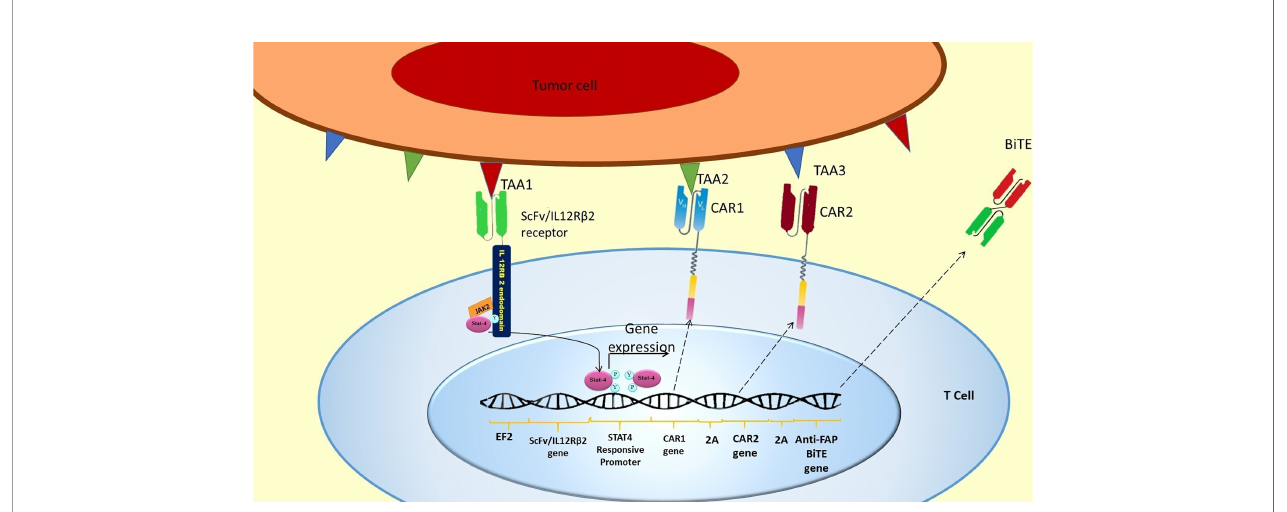
FIGURE 3 | SCFV/IL-12R b 2 receptor induces CAR genes expression. The hypothetically designed cells express ScFv/IL-12R b 2 receptor constitutively before injection. The ScFv/IL-12R b 2 receptor consists of an extracellular domain against tumor-associated antigen 1 and the intracellular domain of b 2 subunit of the human IL-12 receptor. After injection and TAA1 recognition by ScFv/IL-12R b 2 receptor, JAK2 activates and creates a docking site for STAT4 attachment to ScFv/IL-12R b 2 receptor endodomain. This attachment will activate the JAK2/STAT4 signaling pathway and STAT4 mediated gene expression after TAA1 recognition (27, 28). Based on our design, two different CAR receptors and anti-FAP BiTE genes are downstream of STAT4 responsive promoter; therefore, these genes will be expressed in consequence of TAA1 presence. Since a 2A ribosomal skip sequence separates these genes, they will be expressed simultaneously after STAT4 binding to the promoter. After CAR 1 and CAR 2 expression, they could recognize TAA2 and TAA3, respectively, and subsequently activate the CAR T cell.